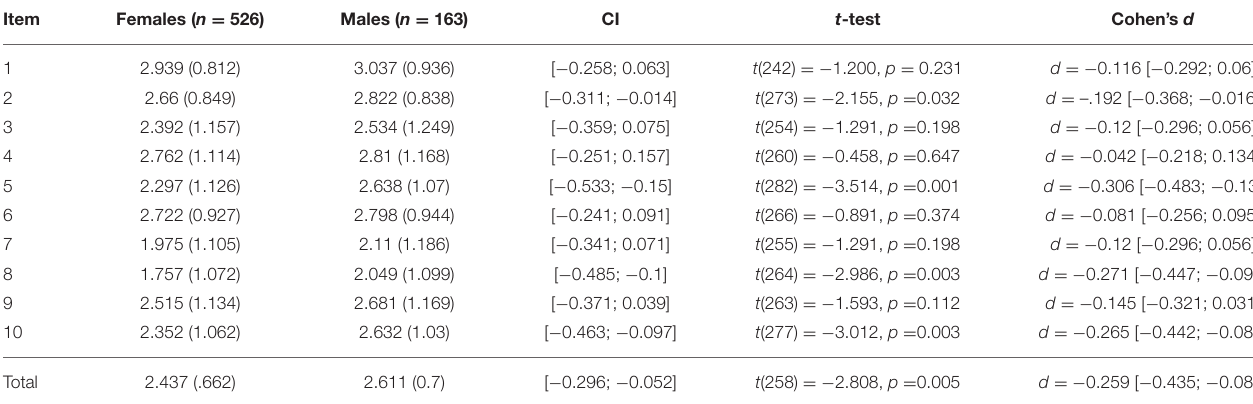
TABLE 2 | Sex differences in the average item and total scores of CD-RISC-10. Item Females ( n =